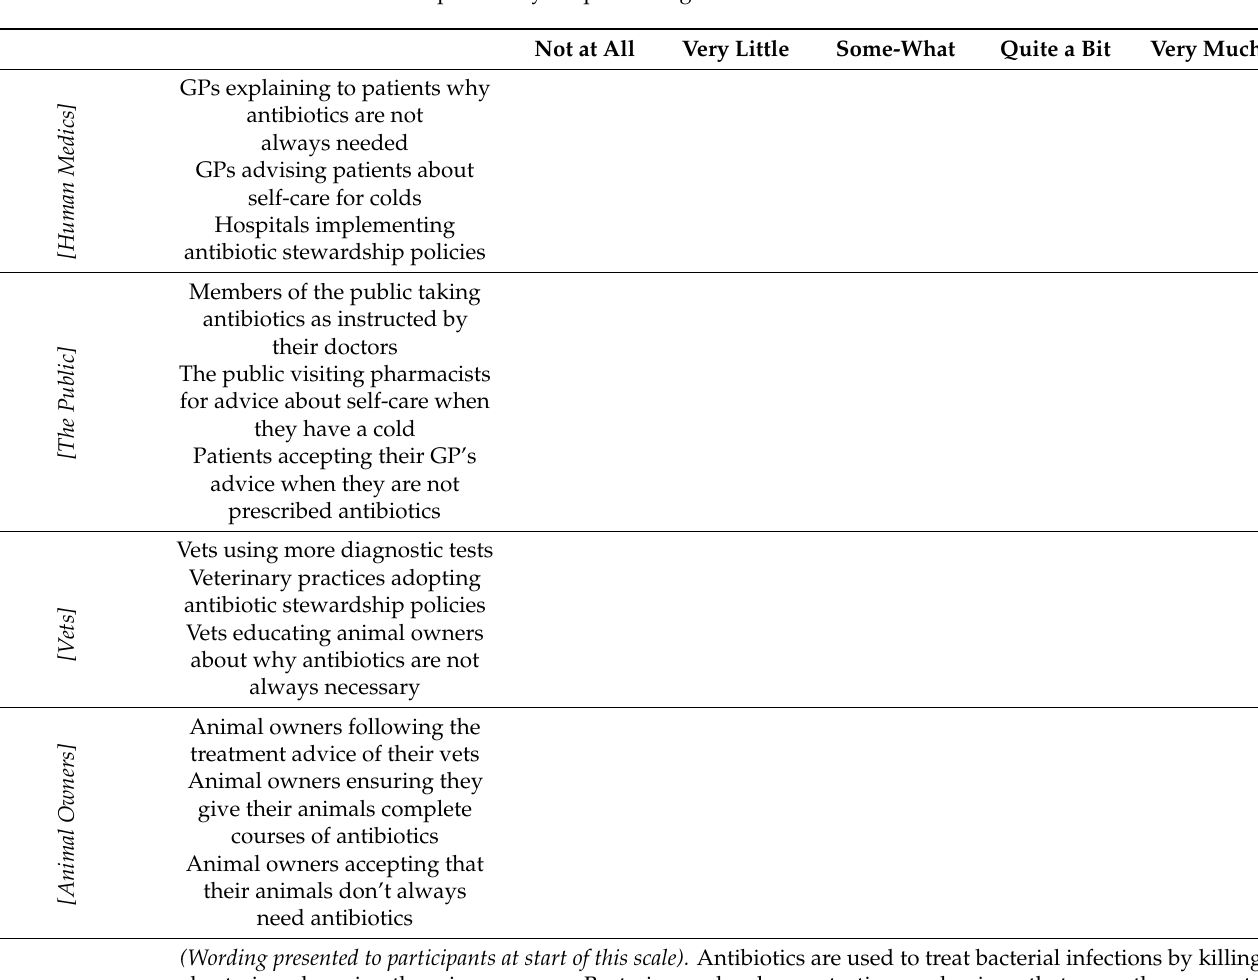
Table A4. Responsibility for preventing ABR scale. Not at